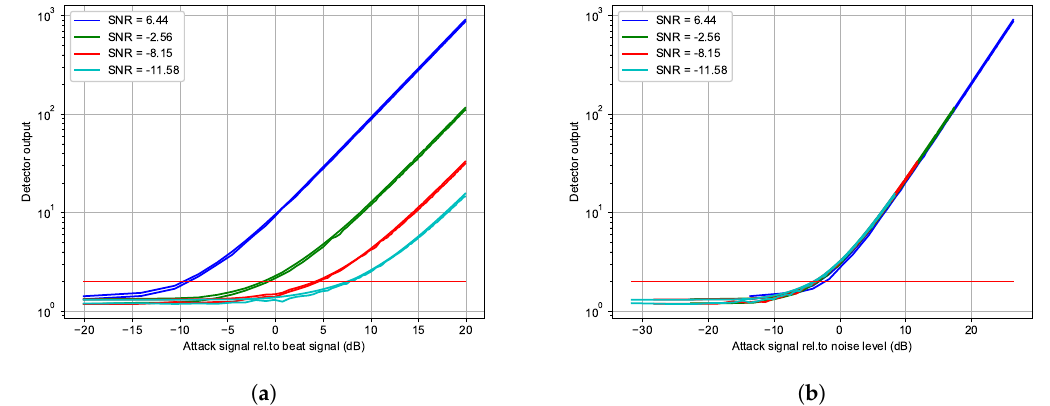
Figure 15. Test case eTX1R. The horizontal orange colored line is the detection threshold. In ( a ) with respect to the beat signal level, and in ( b ) with respect to the noise level.